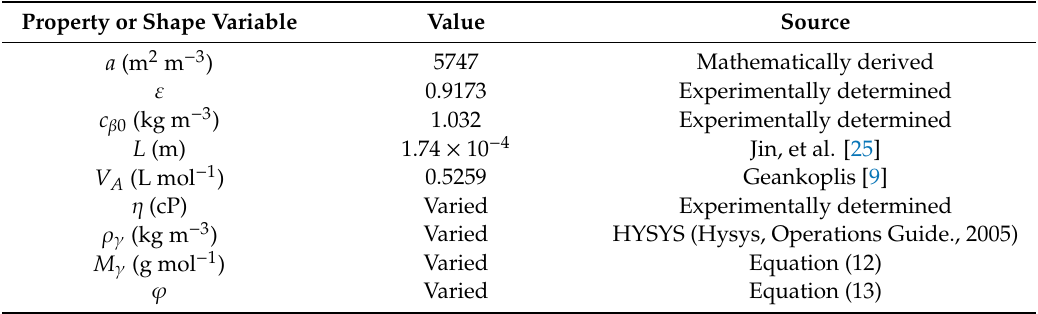
Table 3. Summary of physical properties and shape variables of the experimental extraction system. Property or Shape